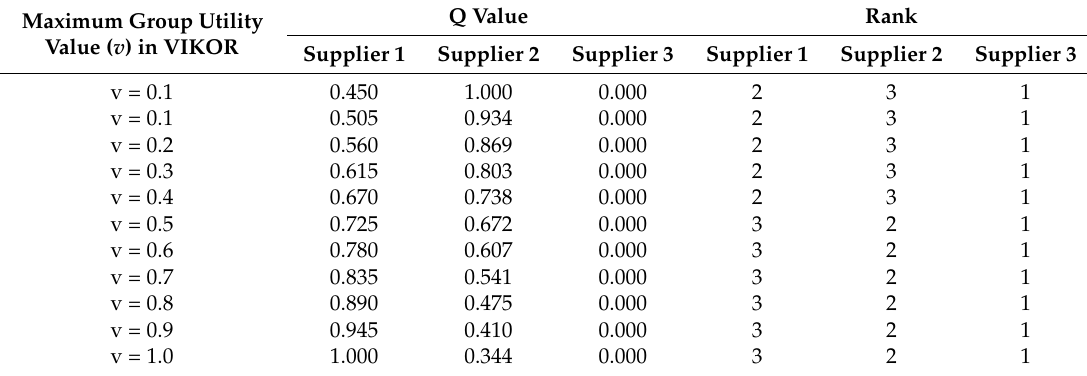
Table 9. Q values and rankings for each supplier in terms of v value